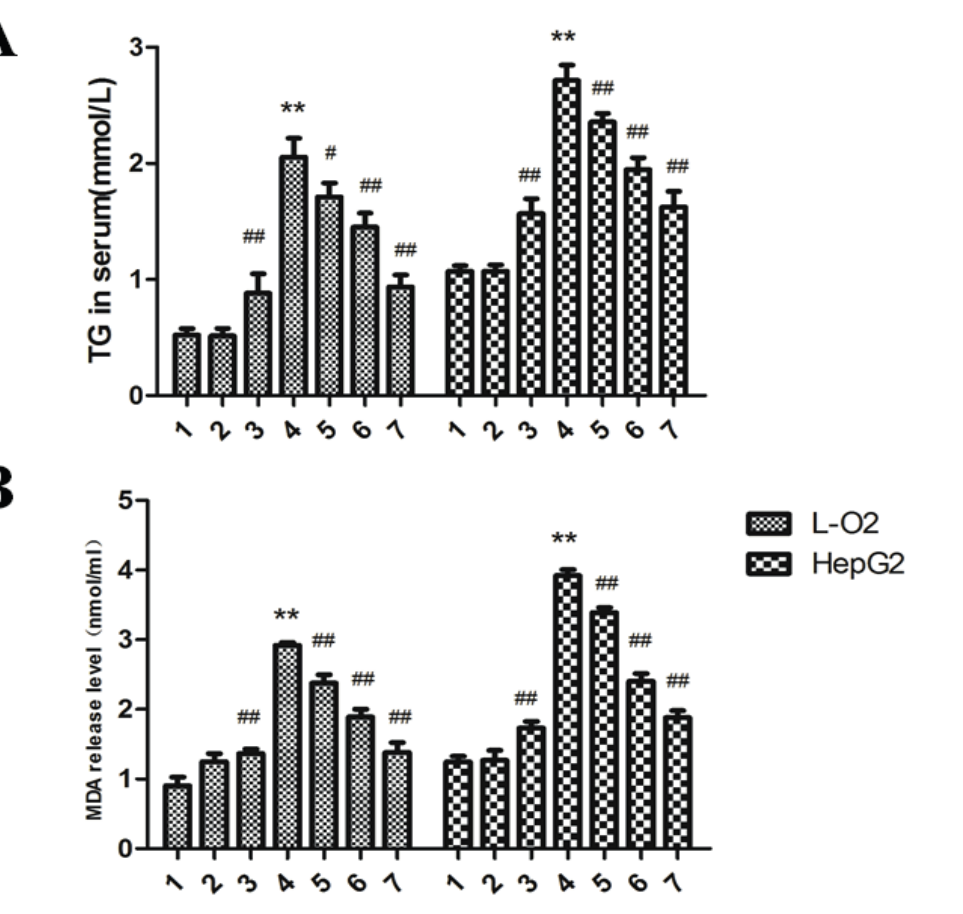
Figure 3: TG and MDA levels in the L-O2 and HepG2 cells treated with different doses. A.TG levels in cells treated with different doses. B. MDA levels in cells treated with different doses. 1: Normal group; 2: blank control group; 3: Fenofibrate group; 4: model group; 5: low dose group; 6: medium dose group; 7: high dose group. *p<0.05, **p<0.01vs the normal group. #p<0.05, ##p<0.01 vs the model